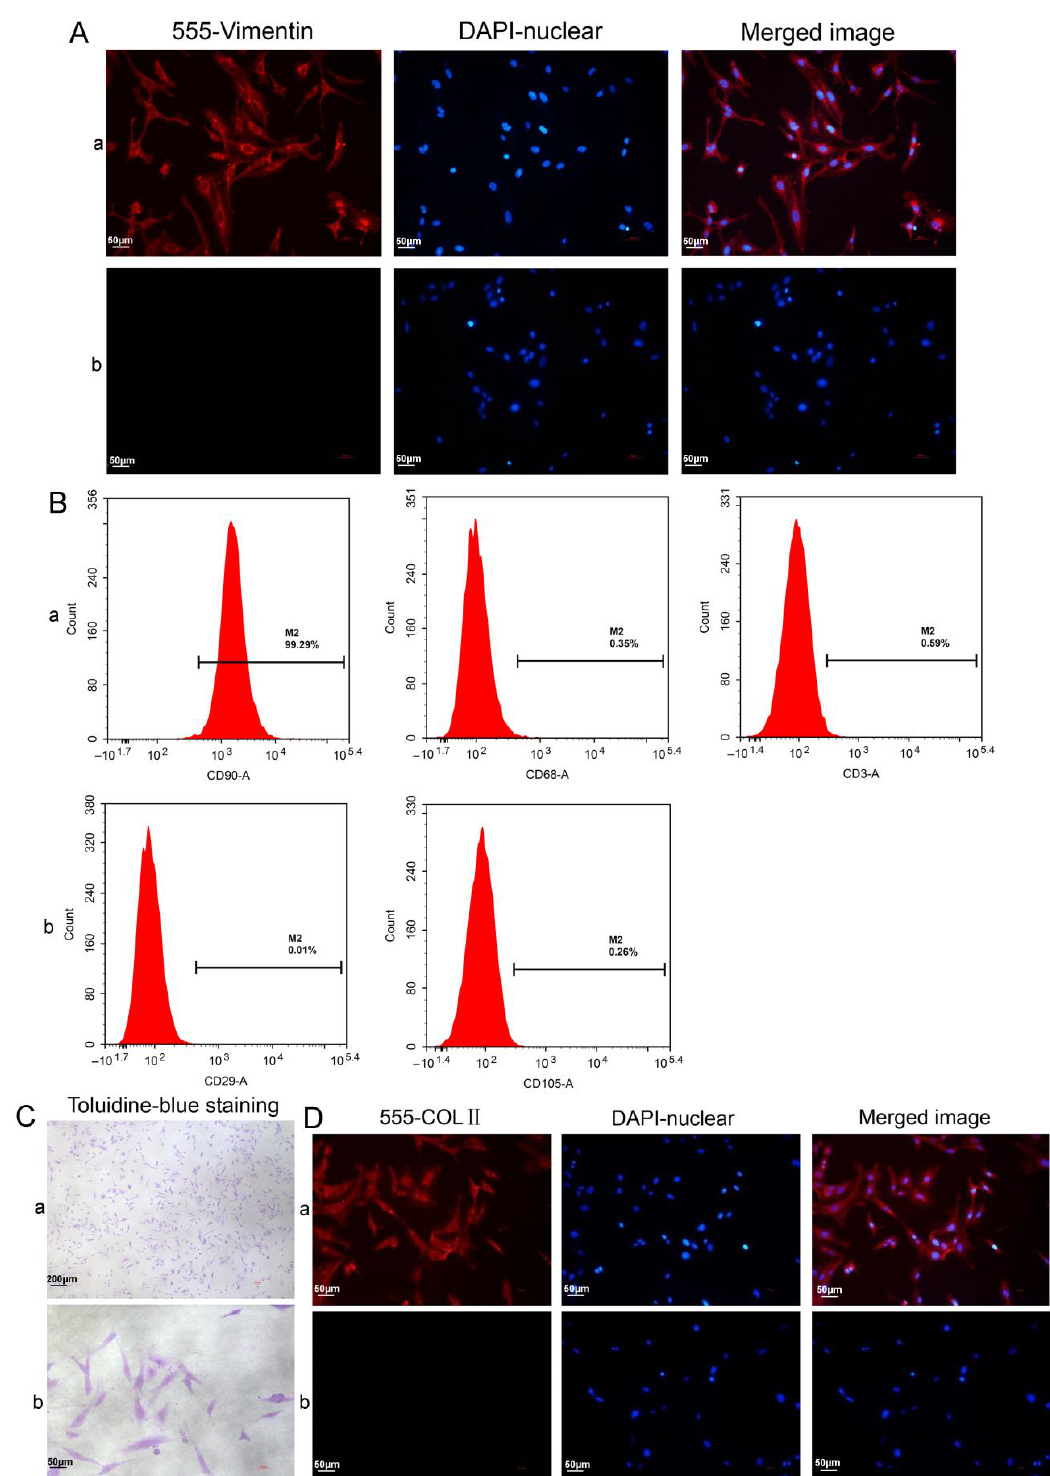
Figure 5. Characterization of the synoviocytes and chondrocytes. ( A ) Vimentin IF staining of FLSs: ( a ) test cells; ( b ) isotype controls. ( B ) The surface markers were analyzed using FCM: ( a ) the synoviocyte surface markers of CD90 (FLSs), CD68 (macrophages), and CD3 (T cells); ( b ) the MSC surface markers of CD29 and CD105. ( C ) Characterization of the chondrocytes using toluidine blue staining. ( D ) Characterization of the chondrocytes with COLII immunofluorescence analysis: ( a ) test cells; ( b ) isotype controls.